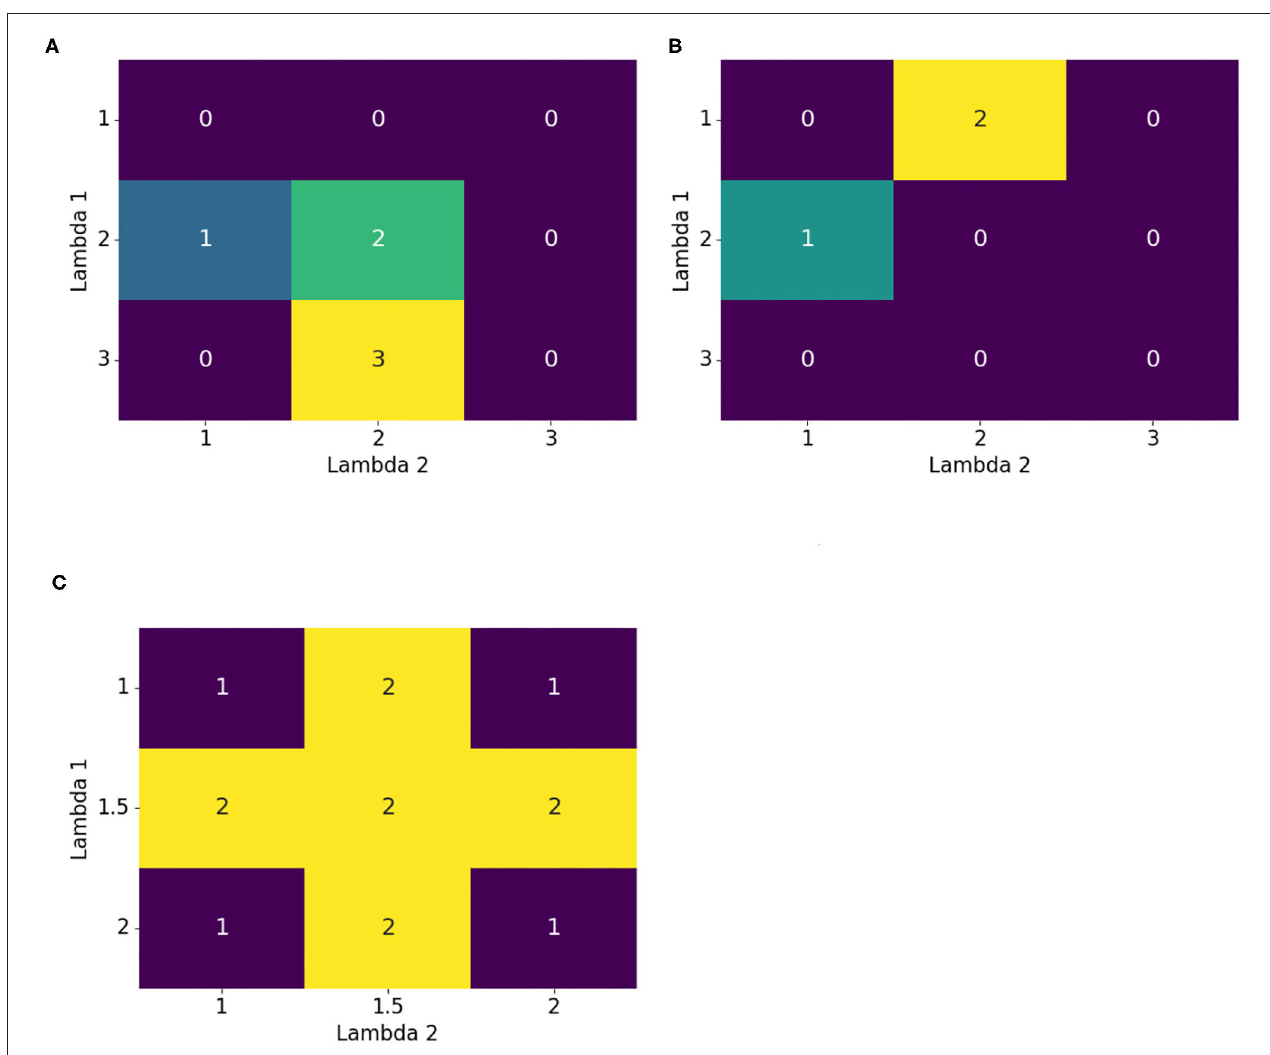
FIGURE 3 | Motivations for improvements to the iterative method. Multiple epochs helped to further advance the optimization to the maximum. Multiple starting points and shuffling were introduced for escaping or avoiding a local maximum, and a finer grid provided the ability to explore hidden details. (A) Multiple epochs, (B) Multiple starting points and shuffling optimization order, and (C) Finer